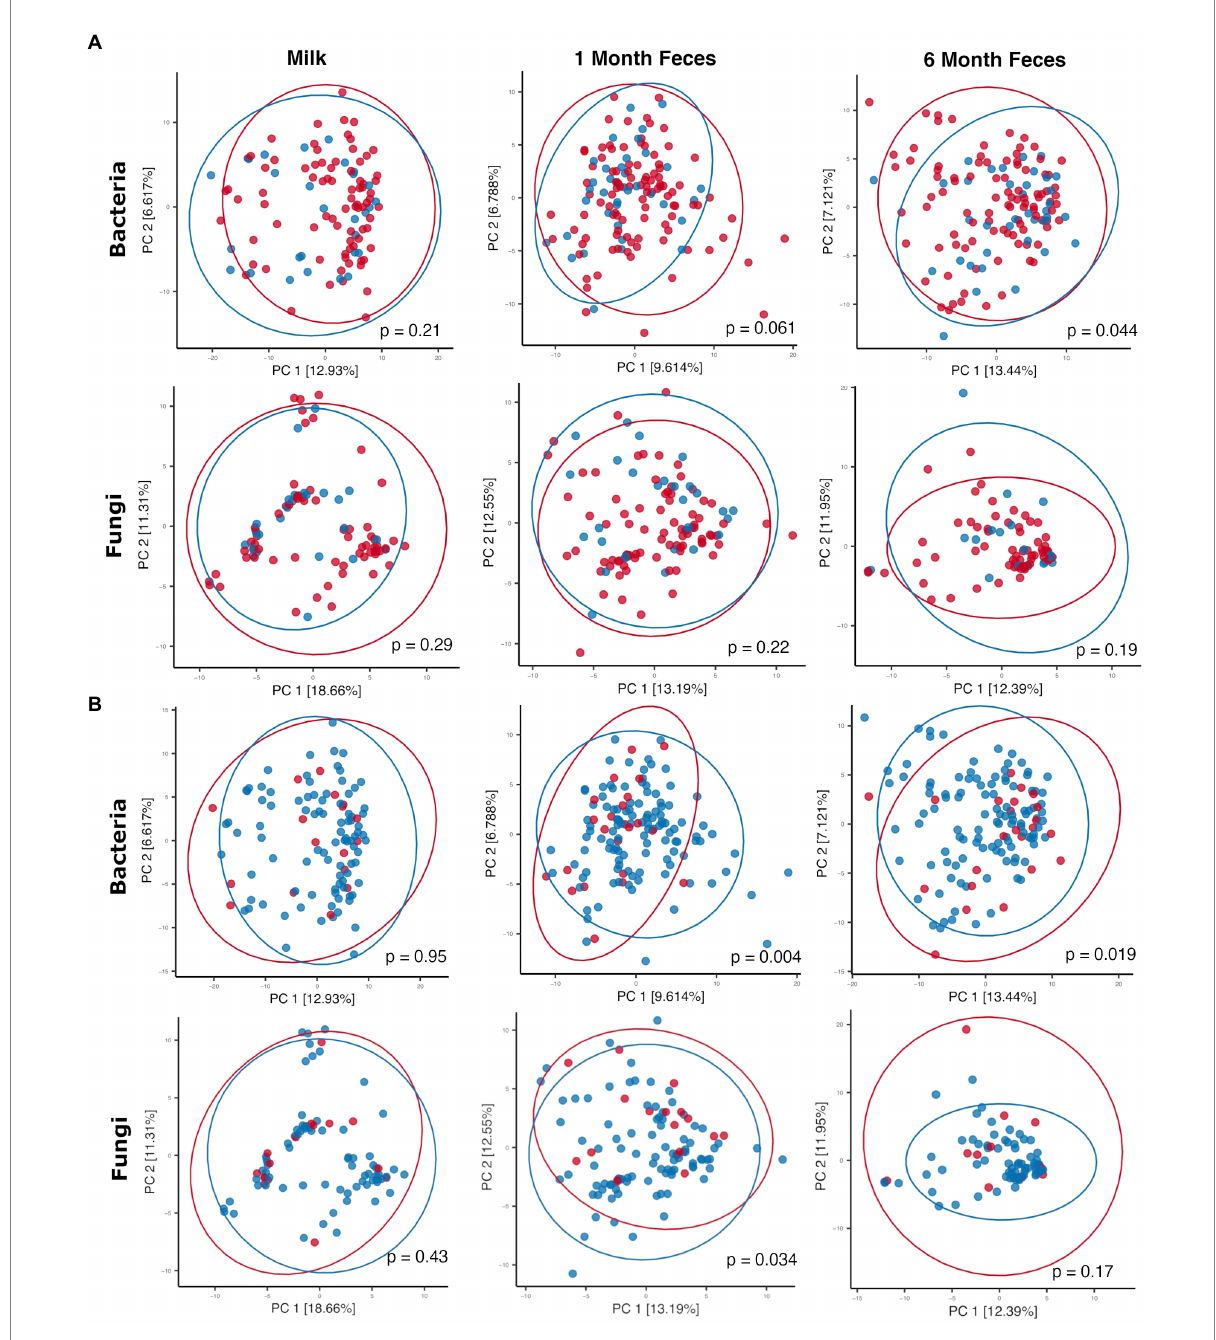
FIGURE 4 Principal coordinates plots comparing microbial communities by (A) perinatal antibiotic exposure (red dots = no exposure, blue dots = positive exposure) and (B) birth mode (red dots = Cesarean section, blue dots = vaginal birth). Ellipses indicate normal probability contours. For A , bacterial community data points (top row): n = 84 for breastmilk, n = 122 for 1-month feces, and n = 95 for 6-month feces; fungal community data points (bottom row): n = 90 for breastmilk, n = 112 for 1-month feces, and n = 83 for 6-month feces. For B , bacterial community data points (top row): n = 84 for breastmilk, n = 122 for 1-month feces, and n = 95 for 6-month feces; fungal community data points (bottom row): n = 90 for breastmilk, n = 112 for 1-month feces, and n = 83 for 6-month